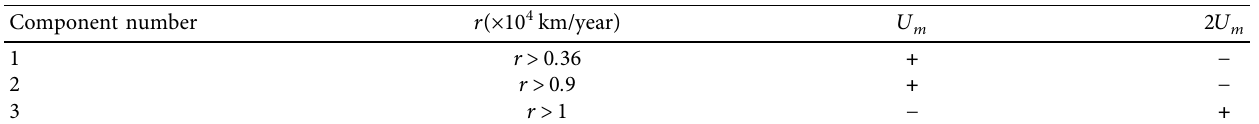
Table 7: PM usage of